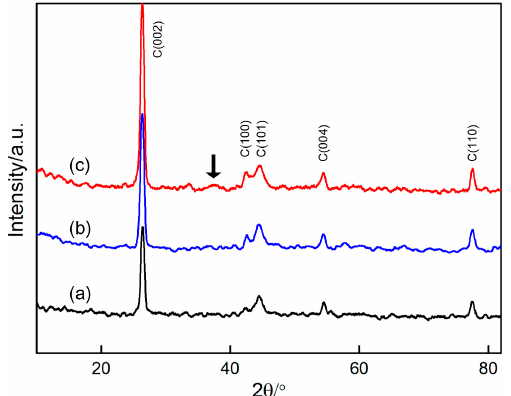
Figure 12. XRD patterns of: ( a ) graphite substrate; ( b ) graphite substrate covered with MnO 2 (deposited for 2 s); ( c ) graphite substrate covered with MnO 2 (deposited for 10 min).